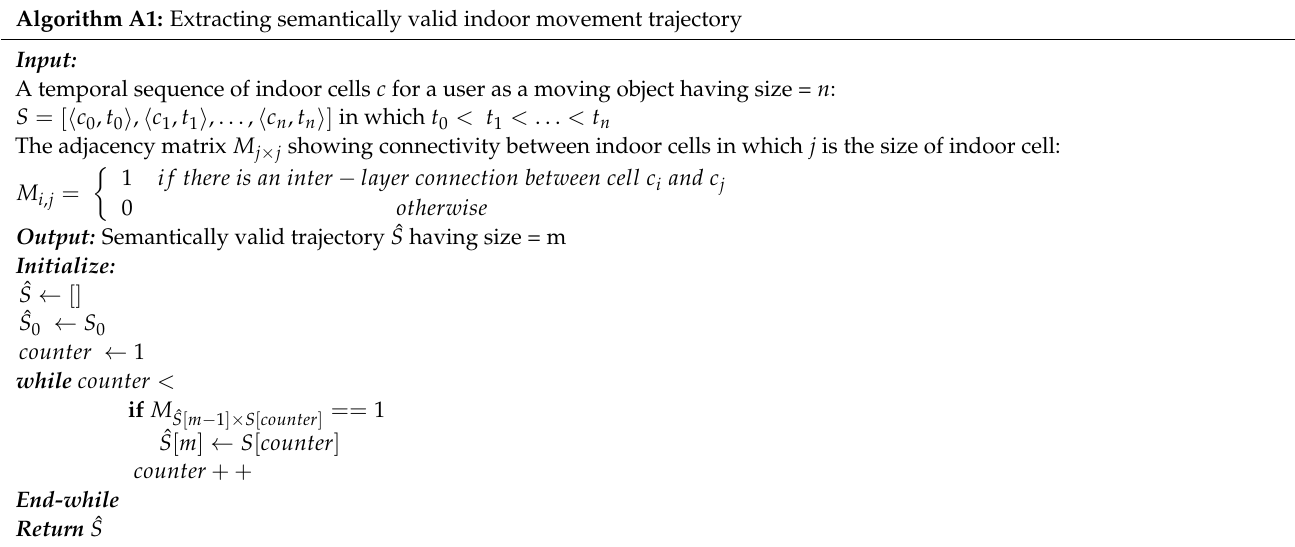
Algorithm A1: Extracting semantically valid indoor movement trajectory